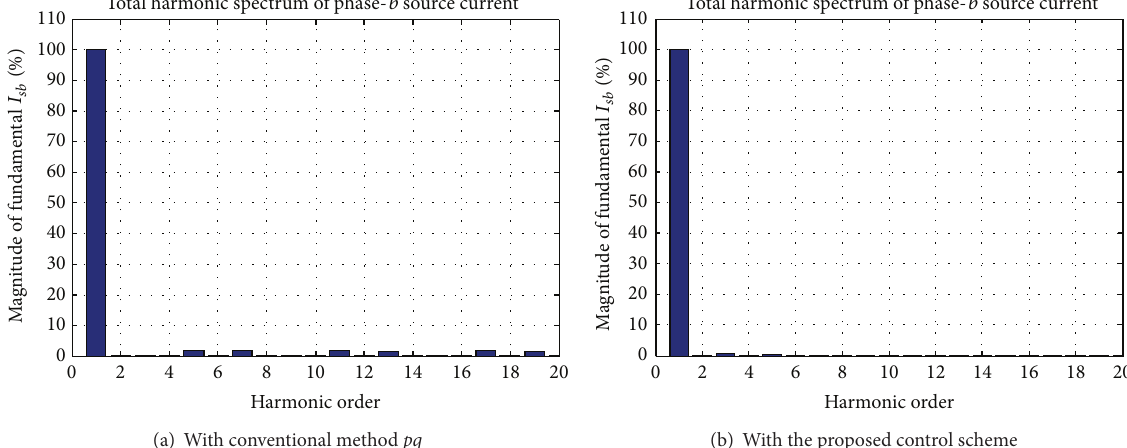
Figure 20: Frequency spectrum phase- b source